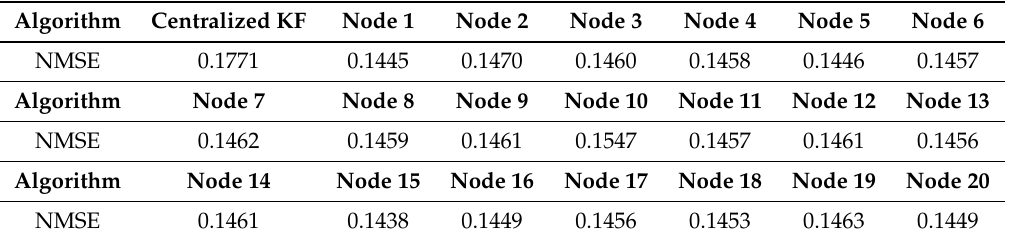
Table 1. NMSEs of the centralized Kalman filter and local filters using Algorithm